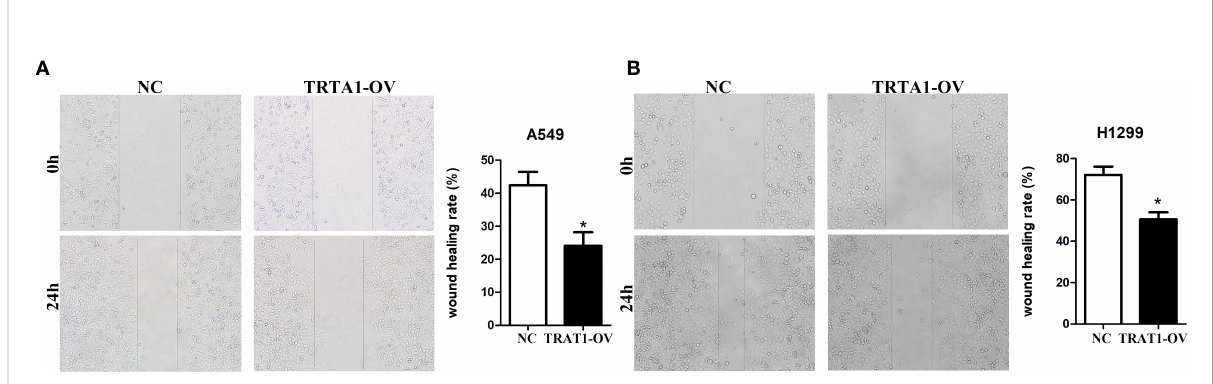
FIGURE 7 Elevated TRAT1 expression inhibited cell migration in LAC A549 and H1299 cells. (A) A549 cells; (B) H1299 cells. LAC, lung adenocarcinoma; *P <